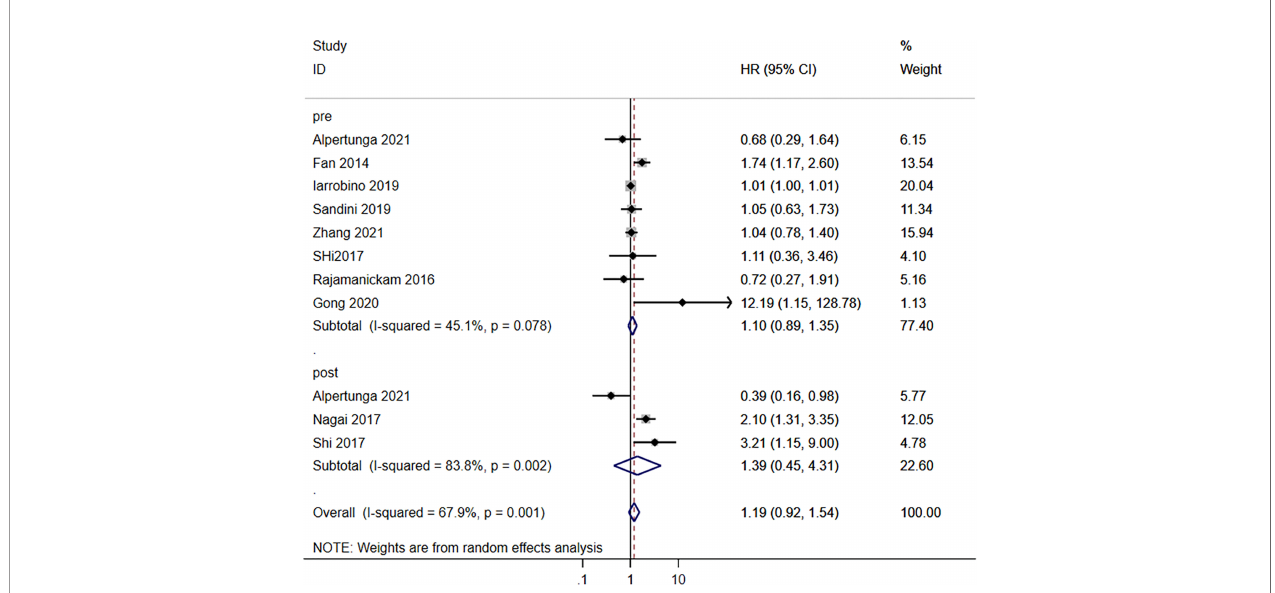
FIGURE 2 | Subgroup analysis of overall survival in the pancreatic cancer population according to the blood glucose levels according to pre- and